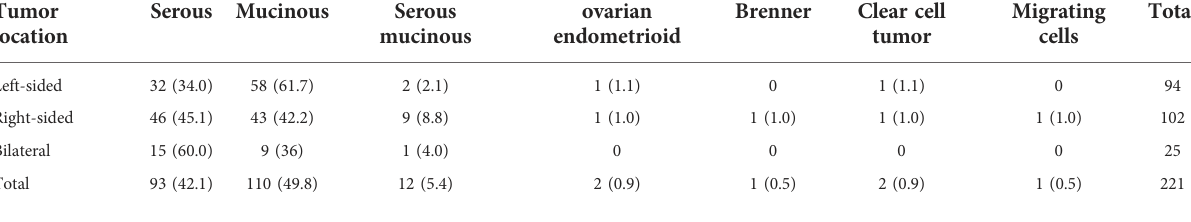
TABLE 1 The pathological data of 221 patients with borderline ovarian tumors (cases and percentages). Tumor Serous Mucinous location